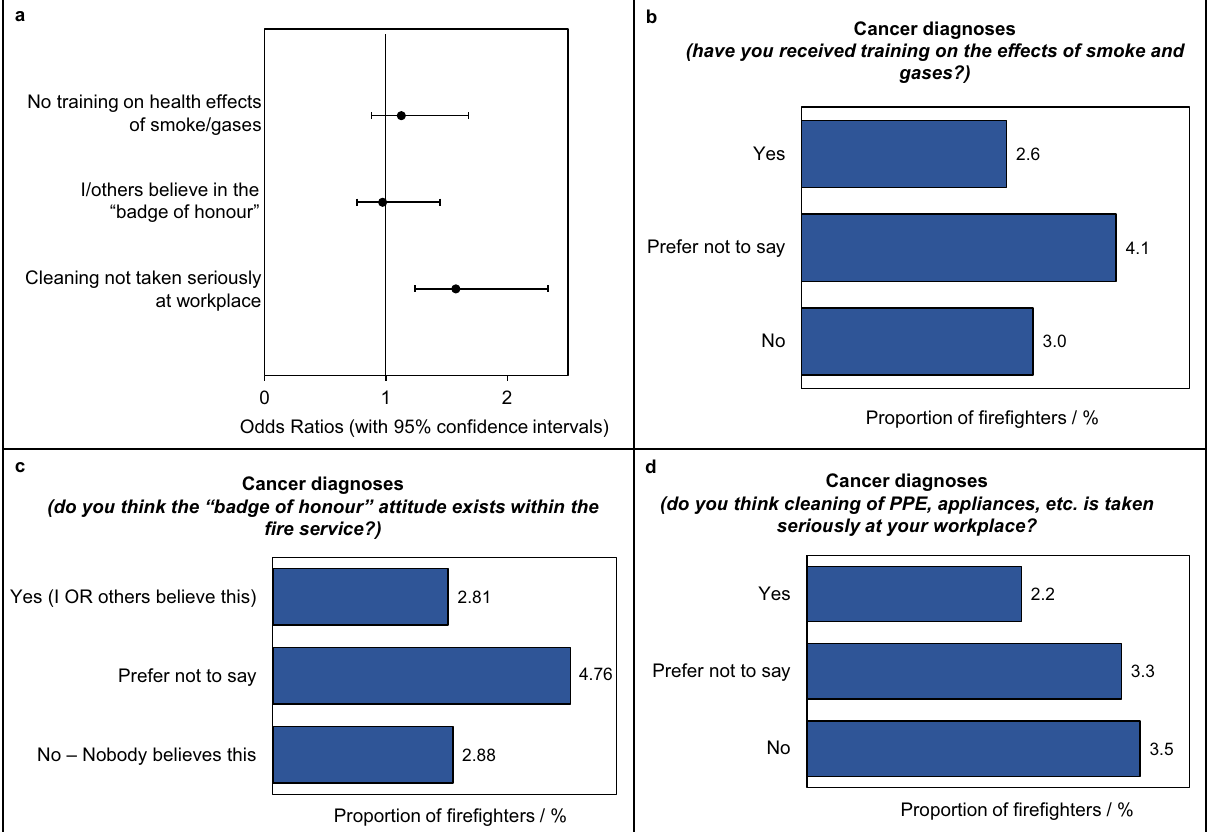
Figure 7. Attitudes, awareness and training and cancer diagnosis in the UK Fire and Rescue Service. ( a ) Cancer odds ratios for measures of contaminant exposure due to attitudes/training. ( b ), ( c ), ( d ) The proportion of firefighters in each training/attitude category who have received a cancer diagnosis. Odds ratios (with 95% confidence intervals) were adjusted for